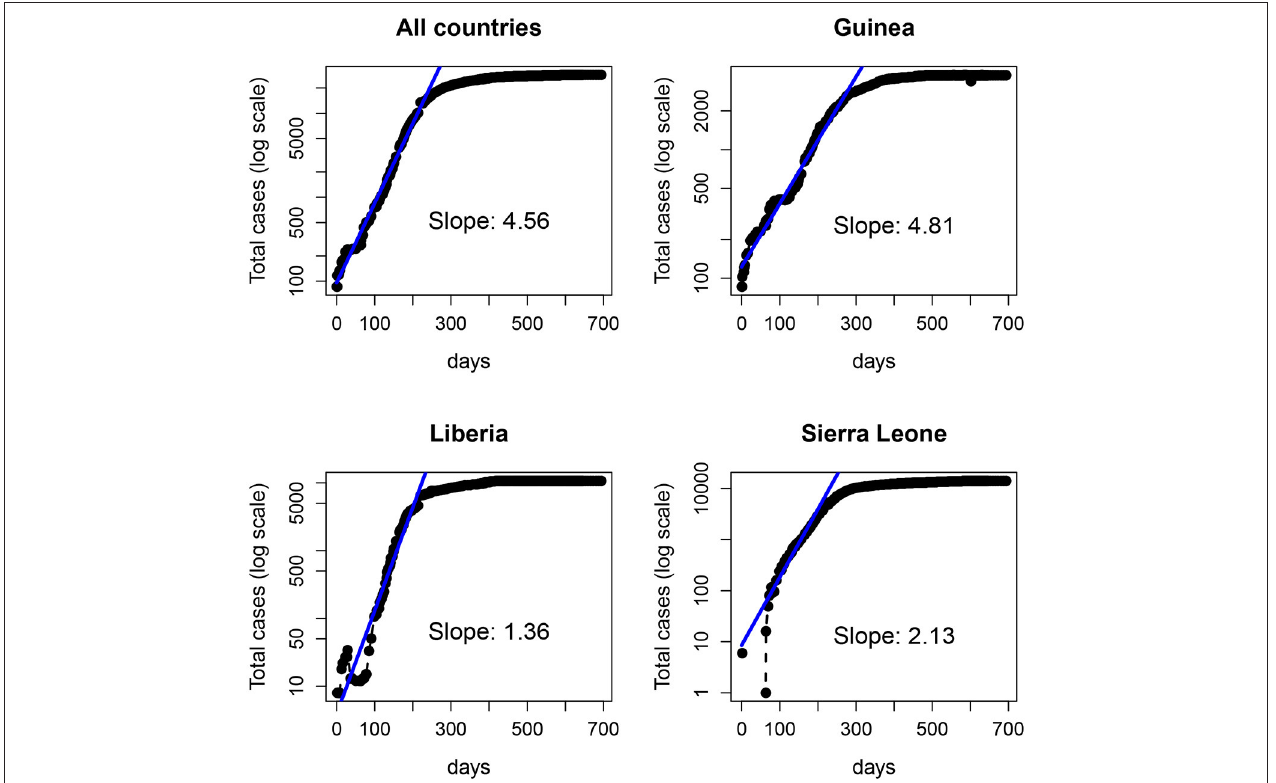
FIGURE 8 | Number of Ebola cases (logarithmic scale) of the 2014-15 Ebola epidemic. (Top left) total number of cases in the three countries: Guinea (Top right) , Liberia (Bottom left) , and Sierra Leone (Bottom right) . The solid line represents the fit of an exponential function to the data in each panel over the first 200 days ( ∼